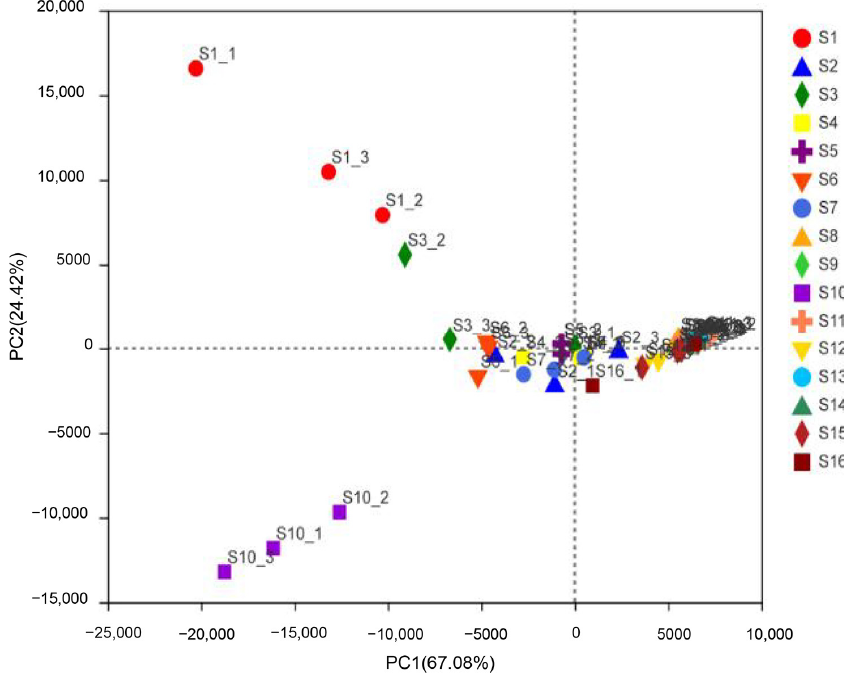
Figure 1. Cluster analysis of bacterial community composition based on principal coordinate analyses (PCoAs) of the beef jerky samples.